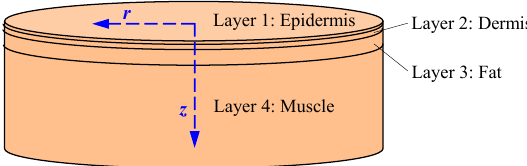
Figure 4. Model of the skin tissue of human body.